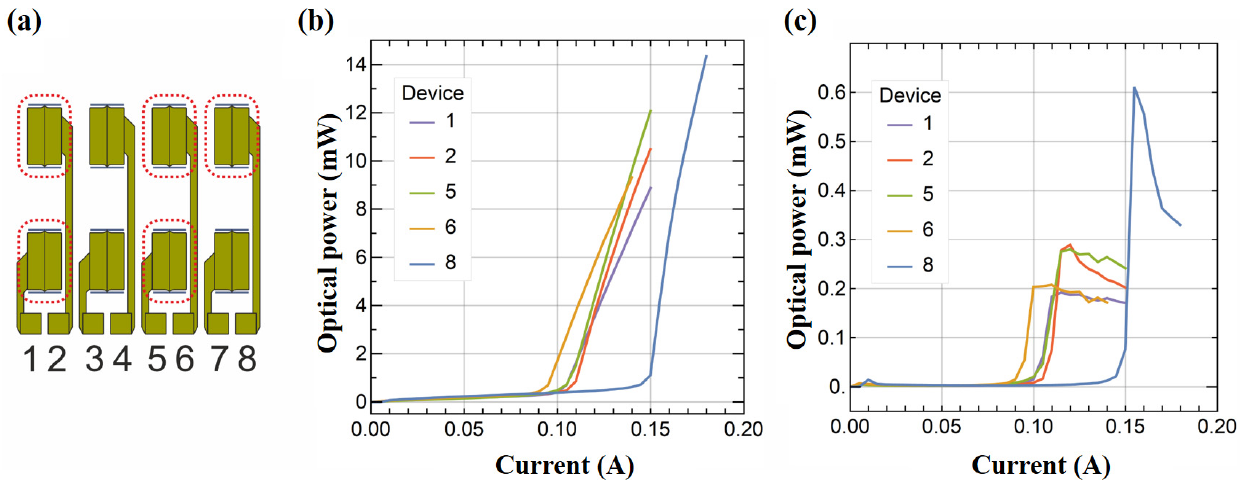
Figure 8. ( a ) 2D array of 4 × 2 emitters, ( b ) light vs. current dependences obtained for a series of edge-emitting devices equipped with the 45° deflectors, and ( c ) corresponding slope efficiency as a dependence on current.